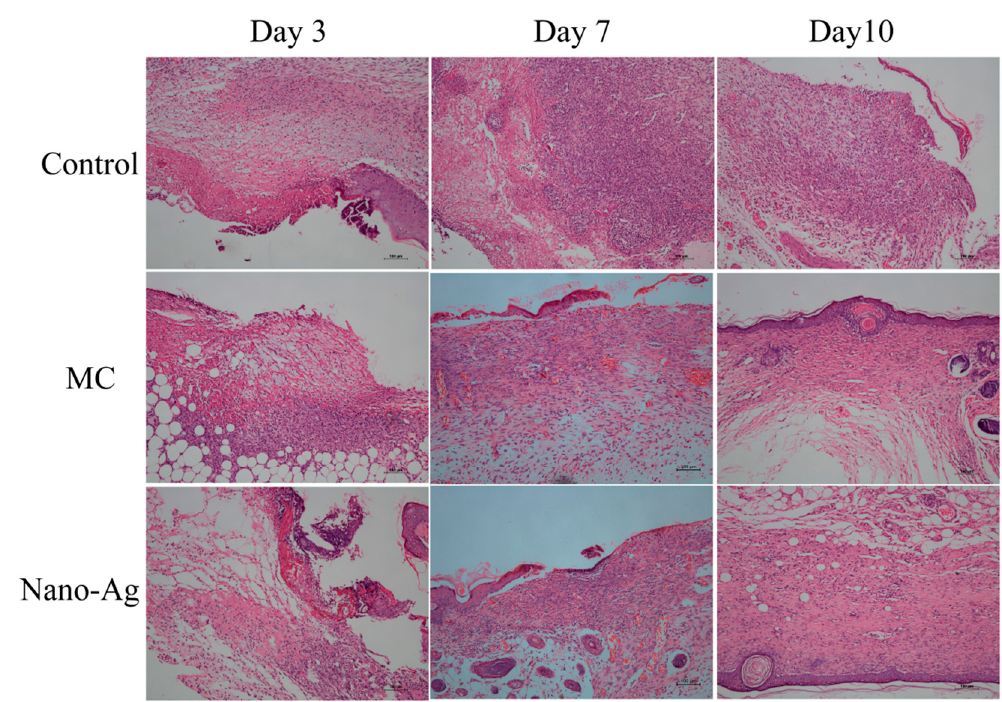
Figure 8. Histological images on days 3, 7, and 10 of the wounds treated with sterile gauze (Control group), multilayer composite membranes (MC group), and Nano-Ag dressing (Nano-Ag